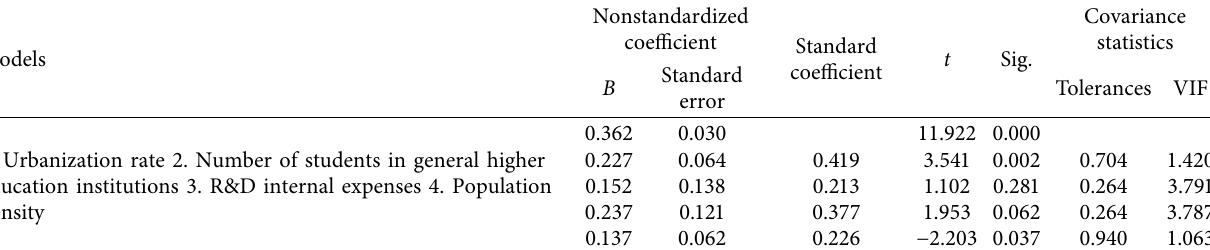
Table 6: Results of multicollinearity